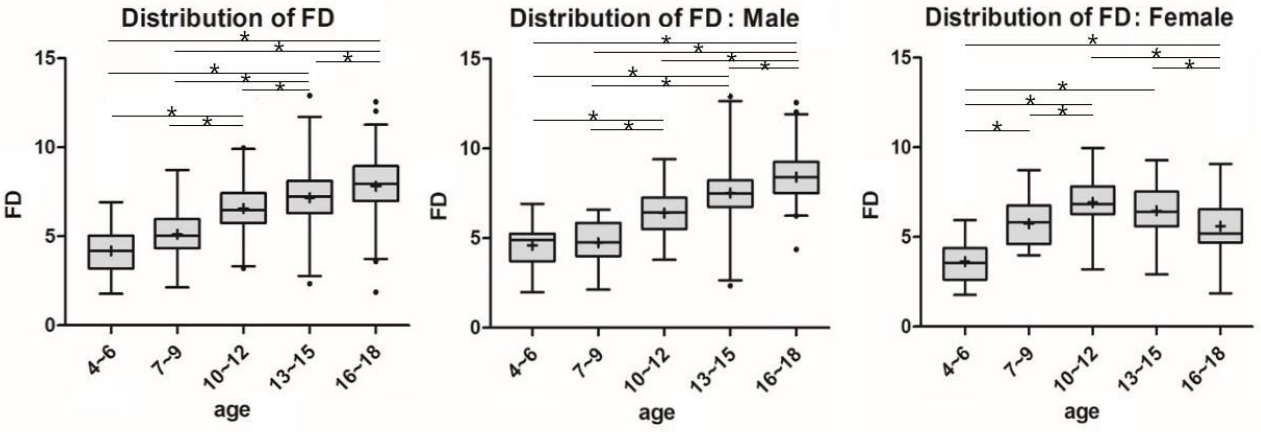
Figure 5. Parametric distribution of femoral depth (FD) in MRI Measurement. The line and the asterisk indicate a significant difference between the two groups using post-hoc analysis. * means the p < 0.05.